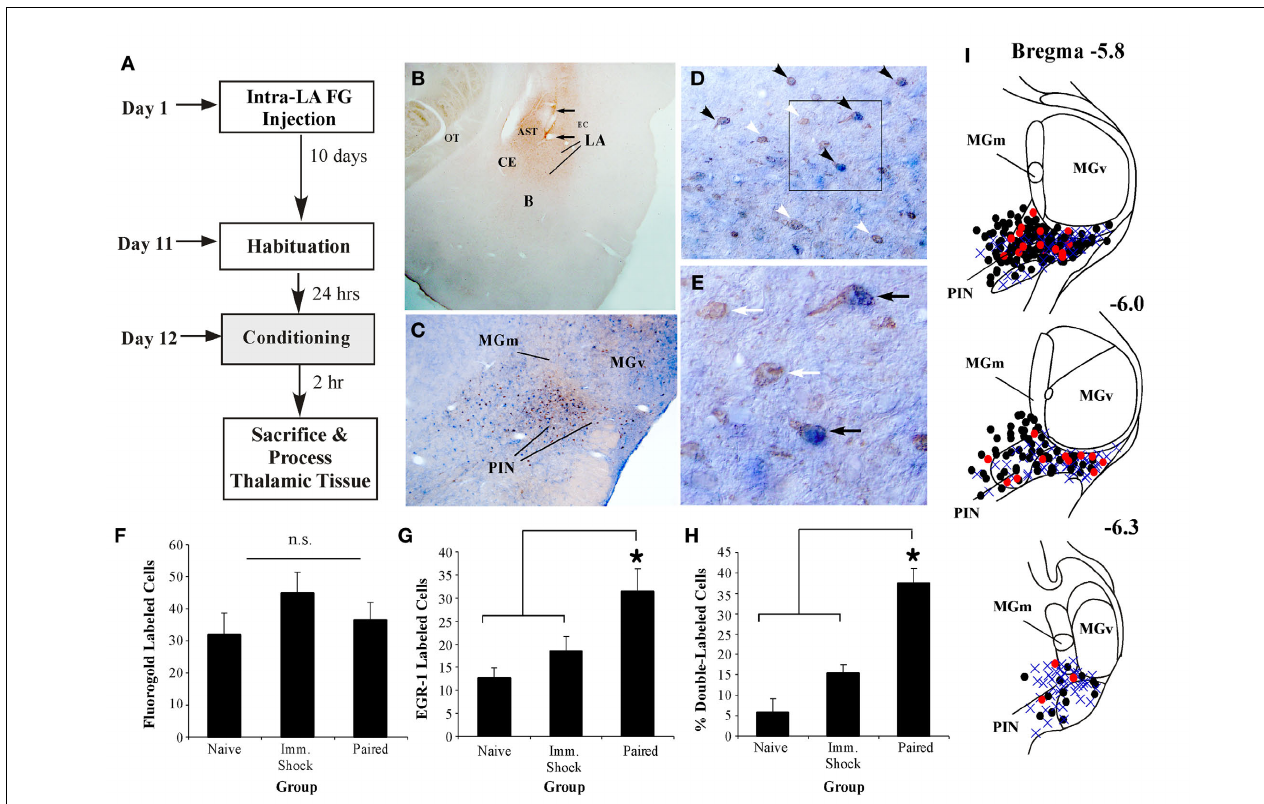
FIGURE 4 | MGm/PIN neurons that express EGR-1 after fear learning project to the LA. (A) Schematic of the behavioral protocol. (B) Representative FG injection site in the LA. The arrows represent the cannula track. (C) Representative 20X image of cells in the MGm/PIN labeled for either FG (reddish-brown stain) or EGR-1 (blue stain). Here, FG is stained with a NovaRED peroxidase substrate (Vector), while EGR-1 is stained with Vector blue alkaline phosphatase substrate (see Materials and Methods). (D) Higher-magnifi cation (20X) images of cells expressing FG, EGR-1, or both labels (black arrows). Single labeled cells are represented by white arrows. (E) Higher-magnifi cation (40X) images of either single (white arrows) or